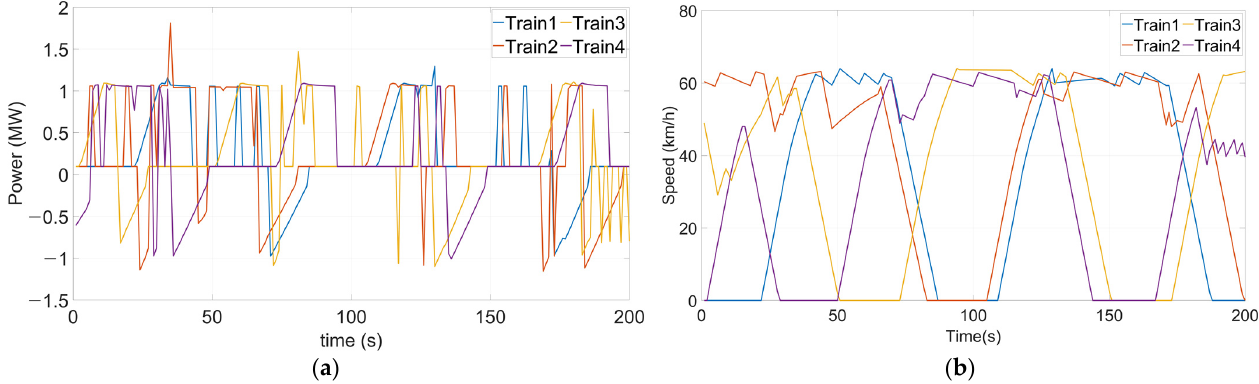
Table 1. Simulation parameters for TPS and DCPS.